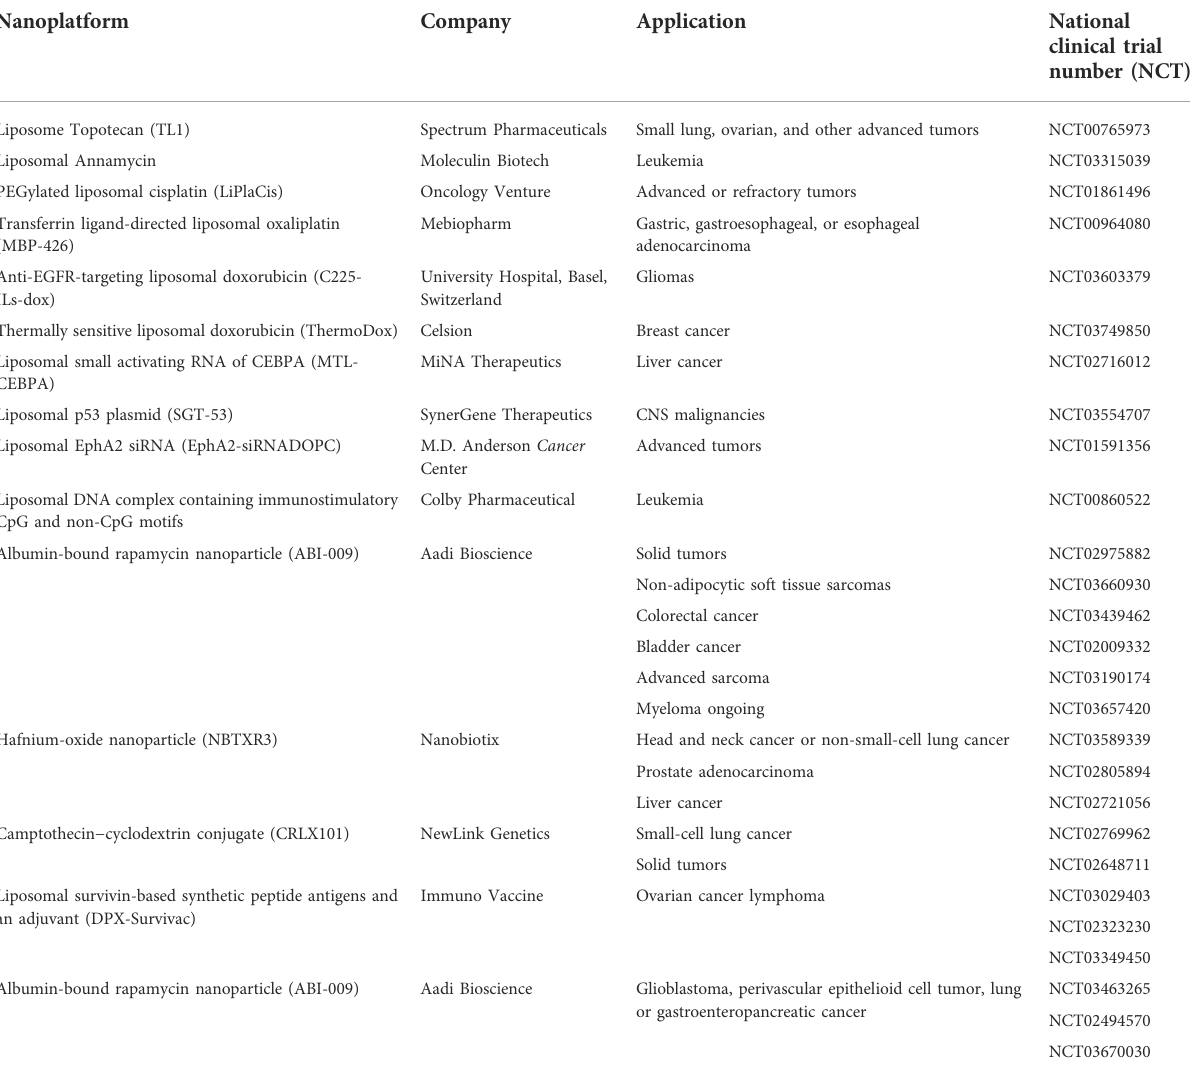
TABLE 2 Nanomedicines undergoing clinical trials.